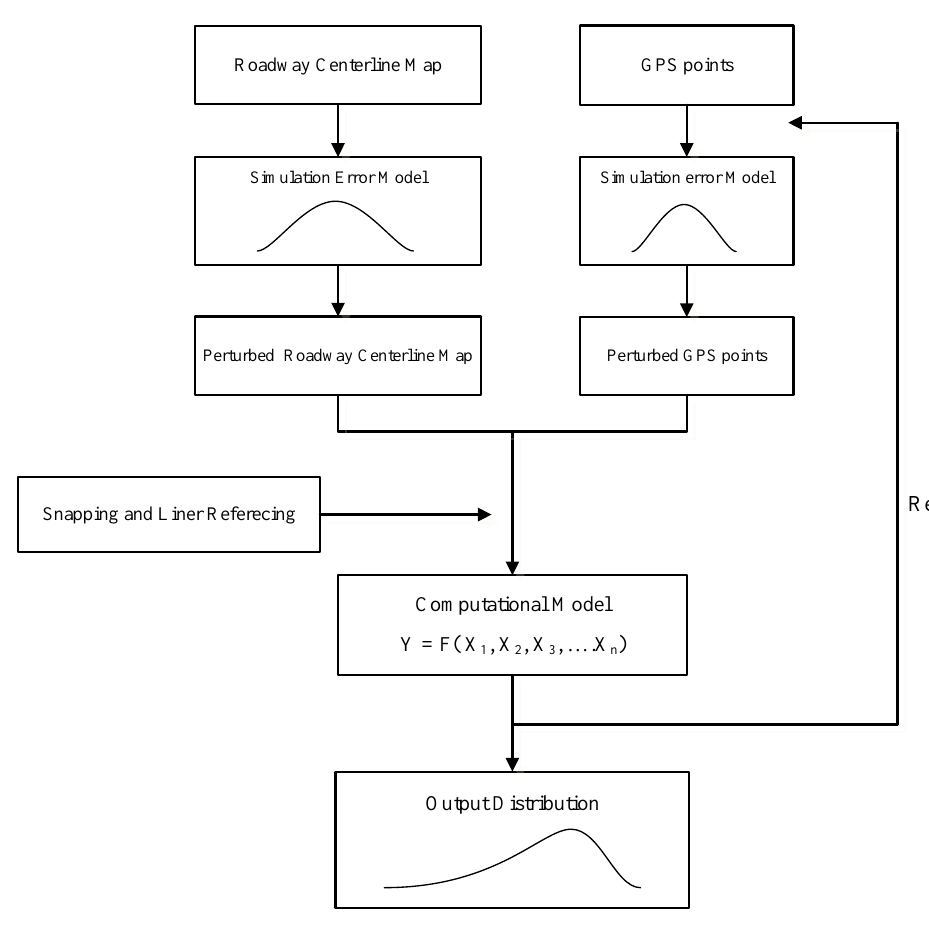
Figure 4. Simulation approach for modeling positional errors in GPS and GIS integrated applications for transportation.